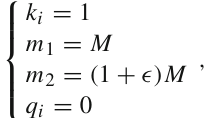
plotted against η . A sign S 0